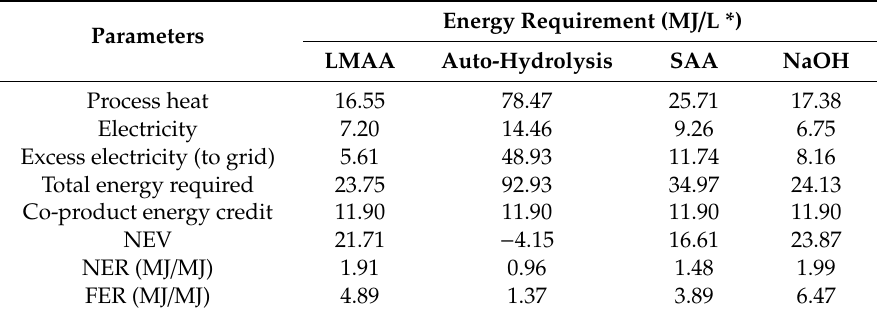
Table 4. Energy metrics of pretreatment technologies